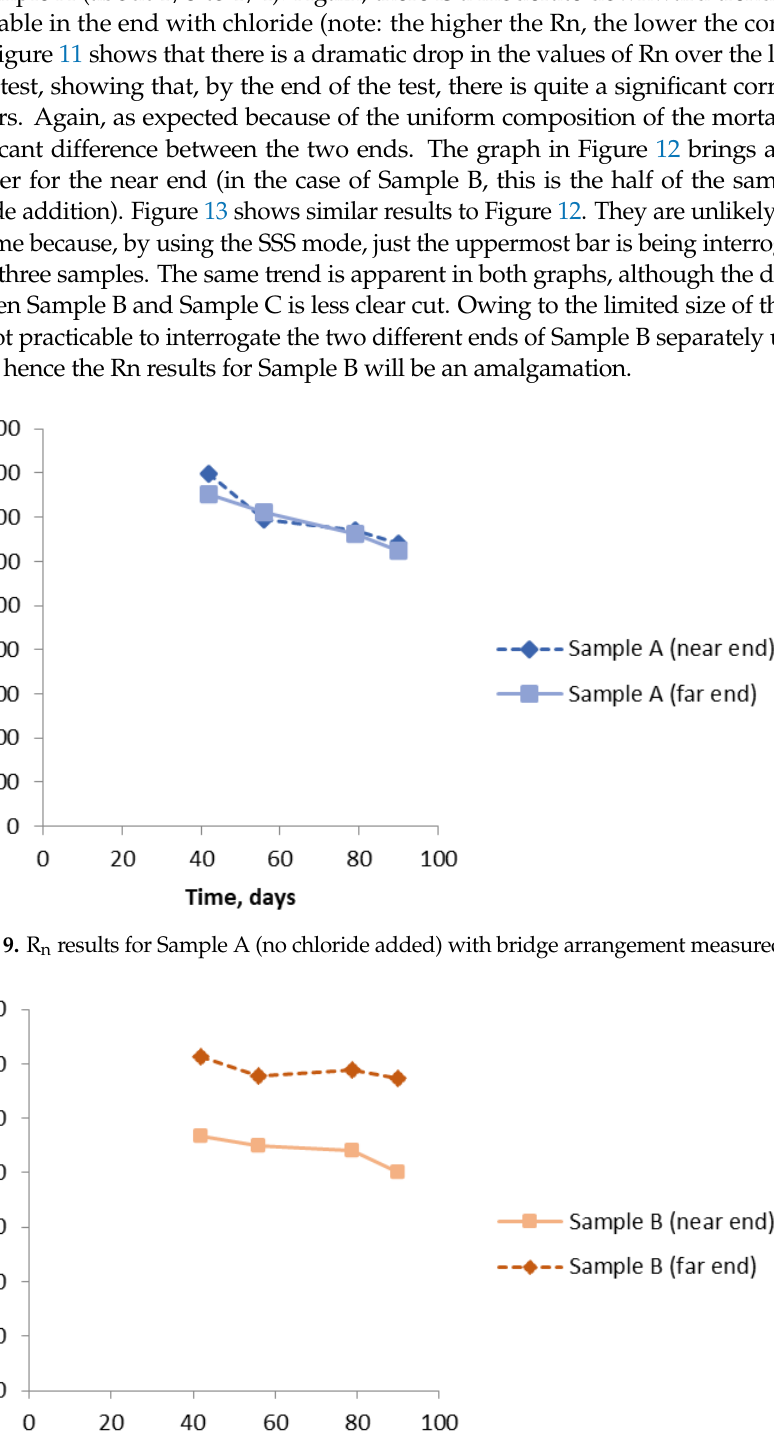
Figure 11. R n results for Sample C (4% chloride levels throughout) using the bridge arrangement. Figure 12. Comparison of R n from all three samples (A, B, and C) with the bridge arrangement. 050100 150